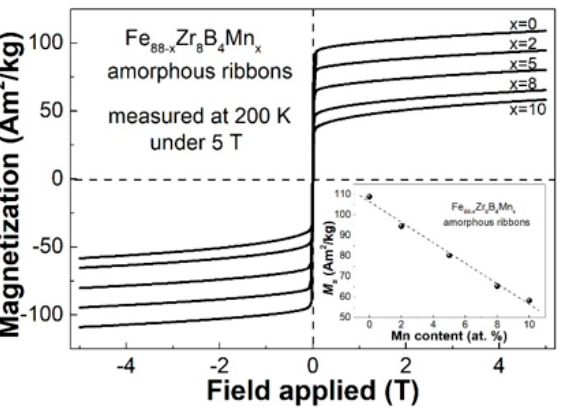
Figure 5. The hysteresis loops of the amorphous Fe 88 − x Zr 8 B 4 Mn x (x = 0, 2, 5, 8 and 10) samples measured at 200 K under 5 Tesla. The inset shows the relationship between the saturation magnetization ( M s ) of the Fe 88 − x Zr 8 B 4 Mn x amorphous ribbons and the Mn content.